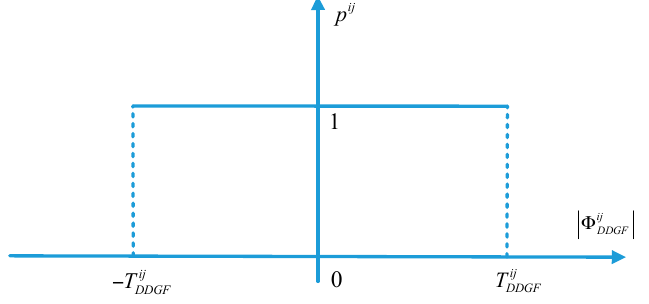
Figure 2. The illustration of the weighting value.